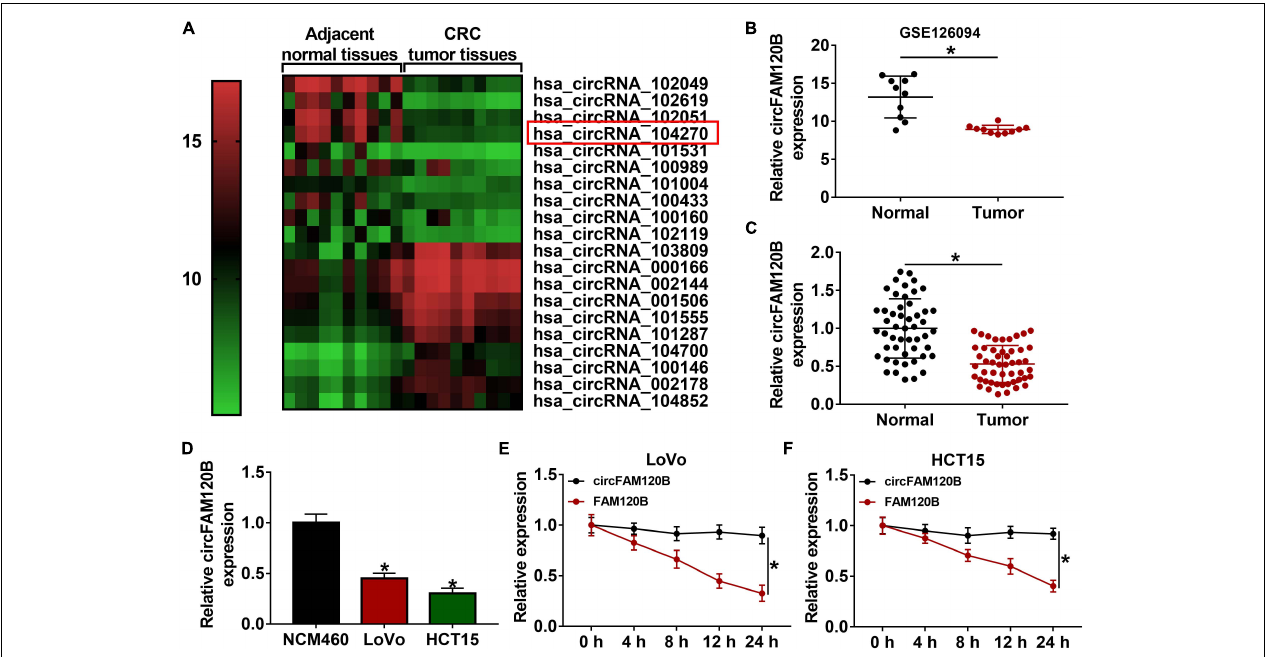
FIGURE 1 | CircFAM120B was downregulated in colorectal cancer (CRC) tissues and cells. (A,B) A microarray profile revealed that circFAM120B was a differently expressed circRNA that was significantly downregulated in CRC tissues ( n = 10). (C) The expression of circFAM120B in tumor tissues ( n = 50) and normal tissues ( n = 50) was detected by quantitative real-time polymerase chain reaction (qRT-PCR). (D) The expression of circFAM120B in LoVo, HCT15, and NCM460 cells was detected by qRT-PCR. (E,F) LoVo and HCT15 cells were exposed to actinomycin D to test the stability of circFAM120B. * P < 0.05.